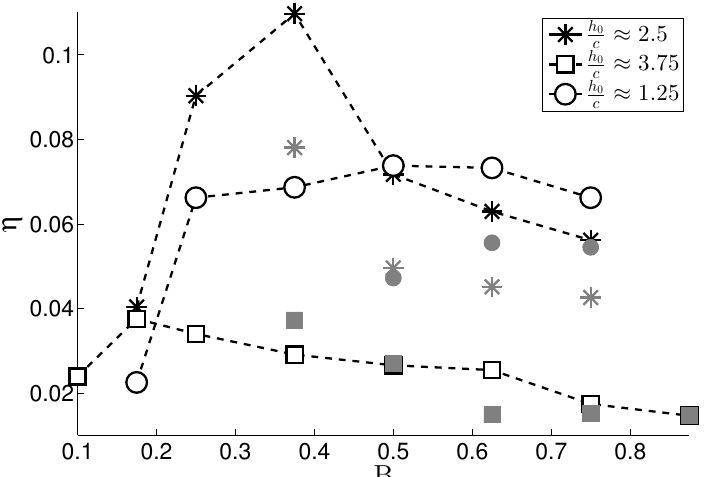
Figure 7. Re = 2 × 10 4 . η vs. B . Markers correspond to different values of h 0 / c : circles: h 0 / c = 1.25; squares: h 0 / c = 3.75; asterisks: h 0 / c = 2.5. Gray markers correspond to same cases with turbulence model applied.